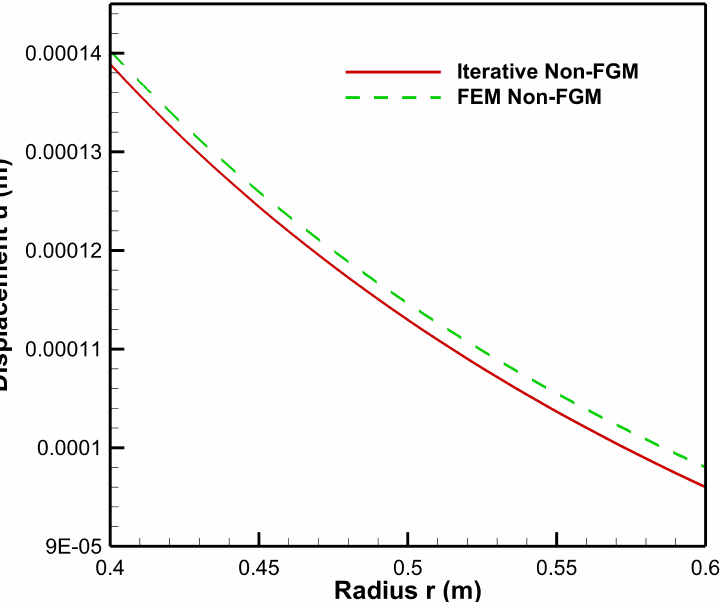
Figure 18. Comparison of displacement along the radius of the cylinder under internal pressure, P a = 50 MPa and external pressure, P b = 20